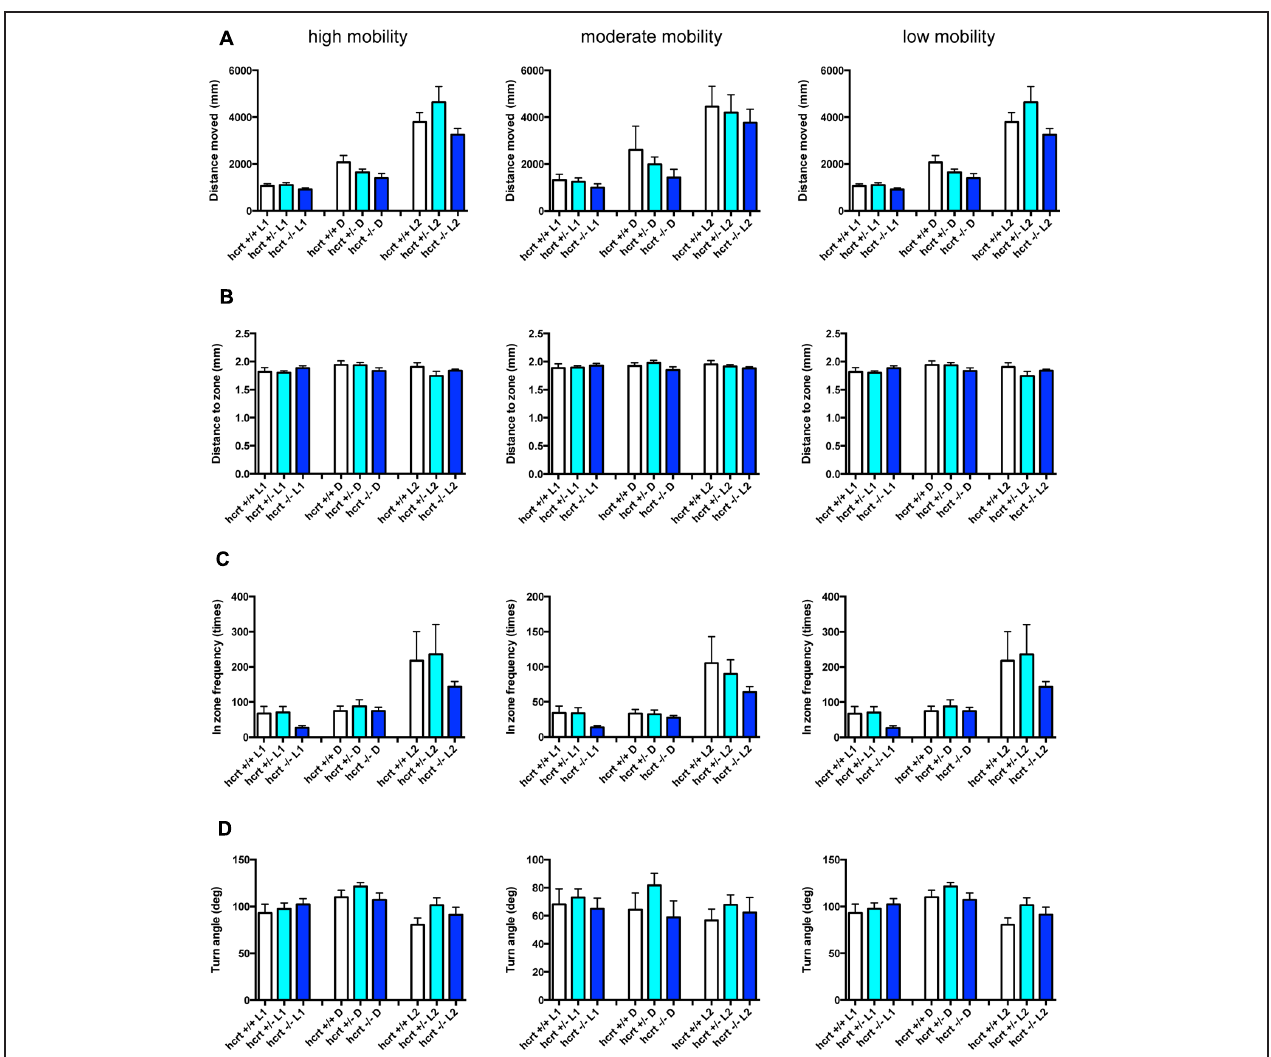
FIGURE 10 | Behavioral profiling of hcrt-KO zebrafish. The behavior of hcrt-KO zebrafish from 9 to 10 dpf were classified into three groups based on their mobility. Distance moved (A) , distance to zone (B) , in zone frequency (C) , and turn angle (D) at L1, D, and L2 periods are shown for each mobility classification. The data are represented as means with the standard error of